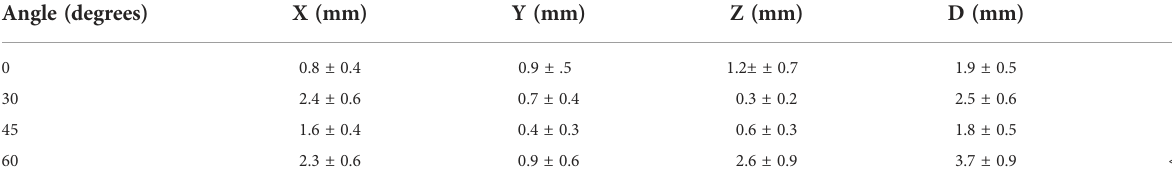
Statistical signi fi cance P 1 : 0 degree vs. other registration